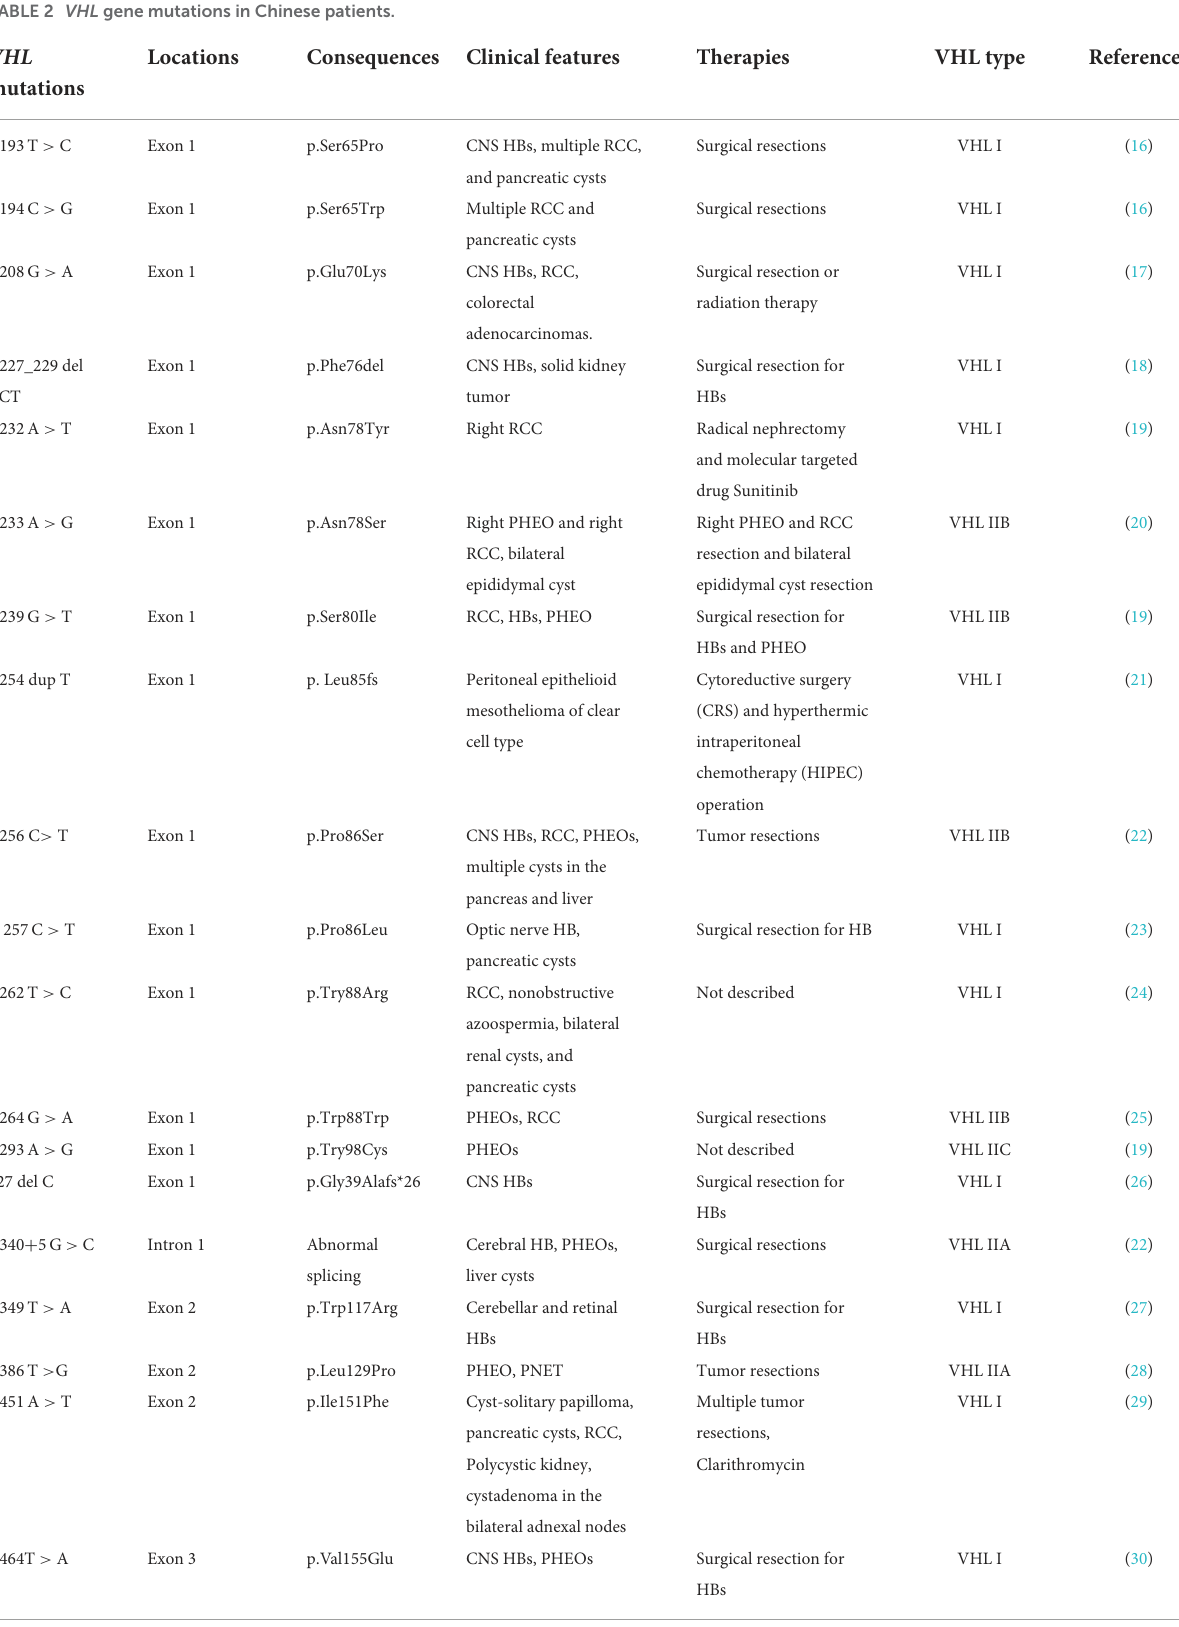
TABLE 2 VHL gene mutations in Chinese patients. VHL